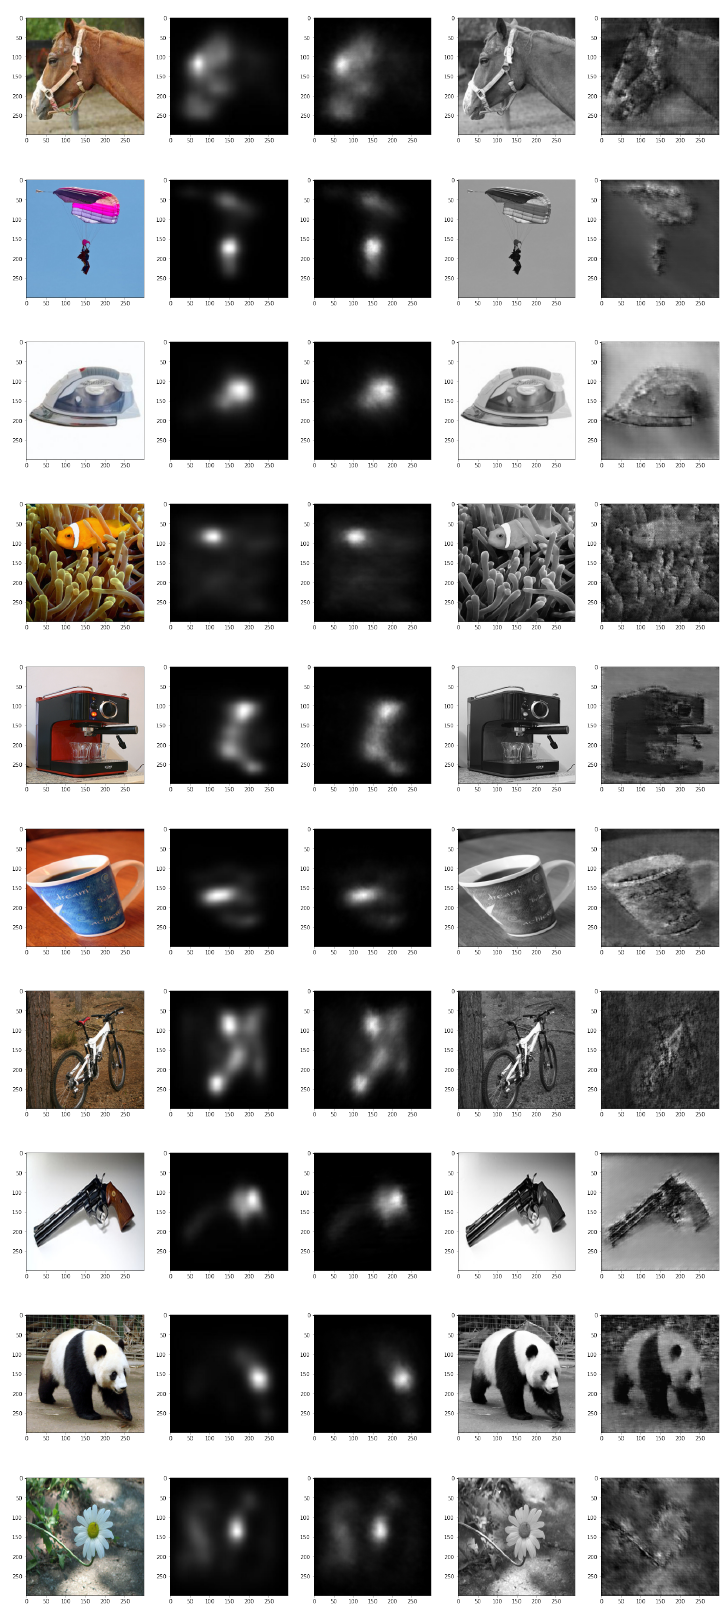
Figure 16. Reconstructed saliency and gray-scale images for categories 1–10; from ( left ) to ( right ): Image used as stimulation, fixation map, EEG-based reconstructed saliency map, gray-scale image, EEG-based reconstructed gray-scale